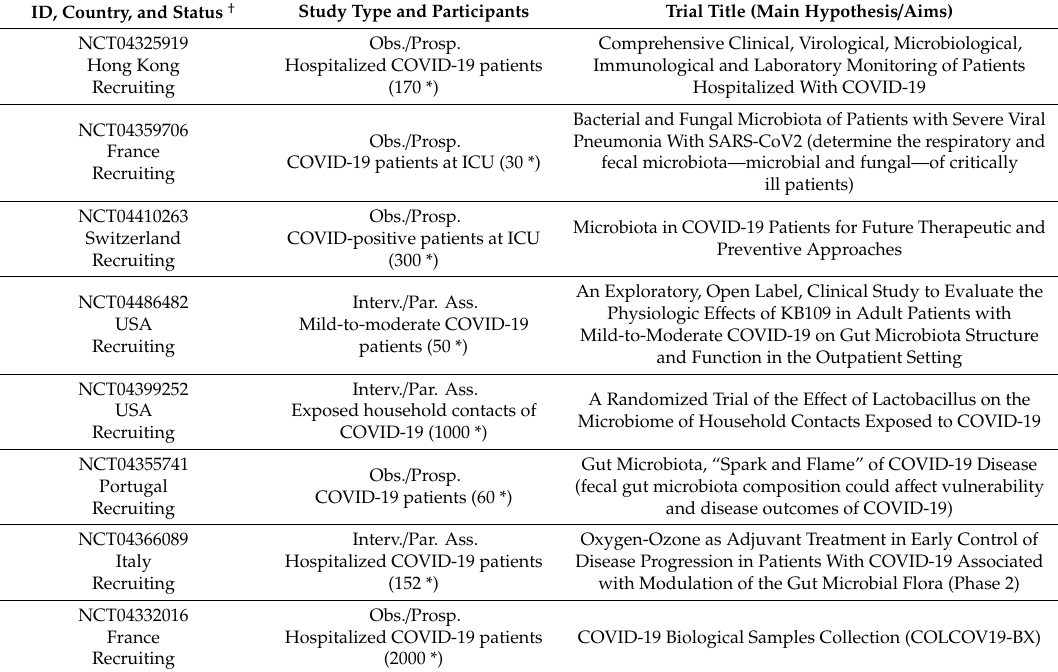
Table 1. Clinical trials with COVID-19 patients for the study of gut microbiota